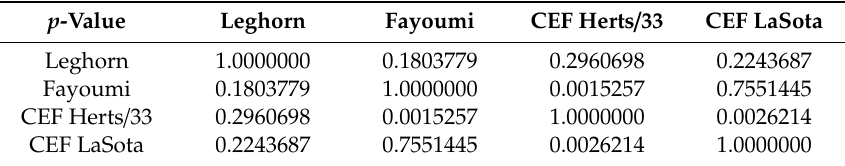
Figure 2. W / V ratio for di ff erent datasets. Figure 2. W/V ratio for different datasets. Table 3. p -values of Student’s t-test for di ff erences in ratio of W / V mRNA. Table 3. p -values of Student’s t-test for differences in ratio of W/V mRNA.